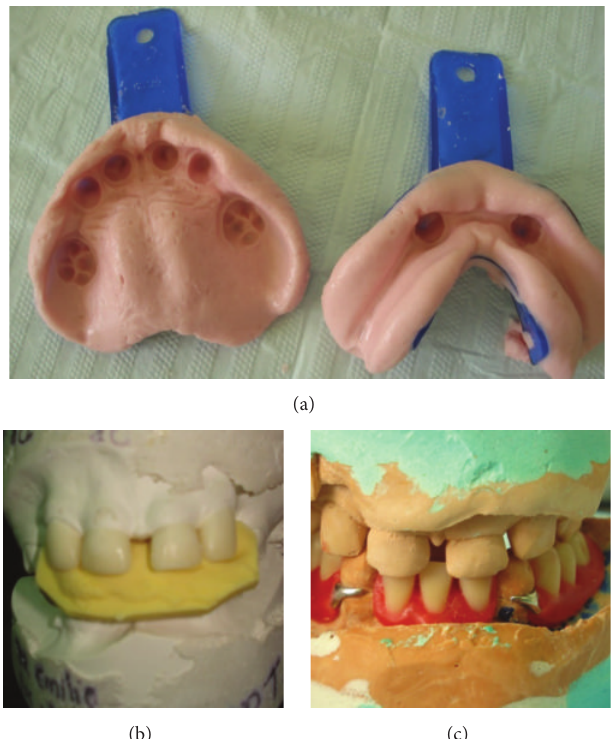
Figure 3: Stages of prosthetic rehabilitation. (a) Upper and lower impression. (b) Template for maxillary tooth restorations. (c) Mandibular partial dentures.